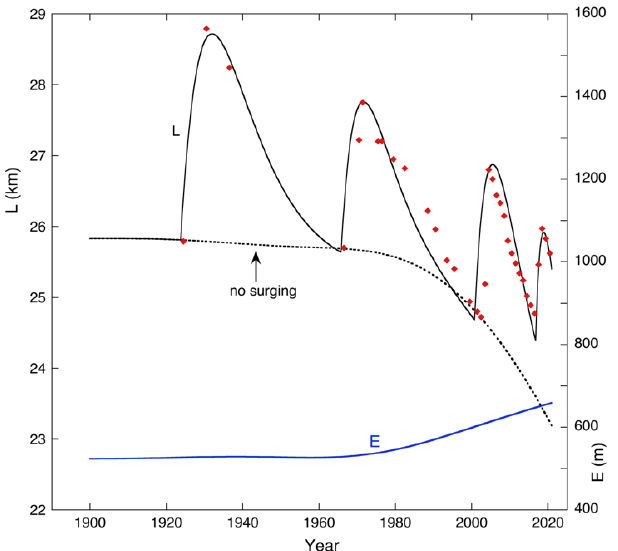
Figure 8. Simulation of glacier length L with ELA LYR as climate forcing (scale at right). Observations are indicated by red dots. The simulation shown by the solid line is tuned to the first observed glacier length (1926); the dotted line is tuned to the last observed glacier length